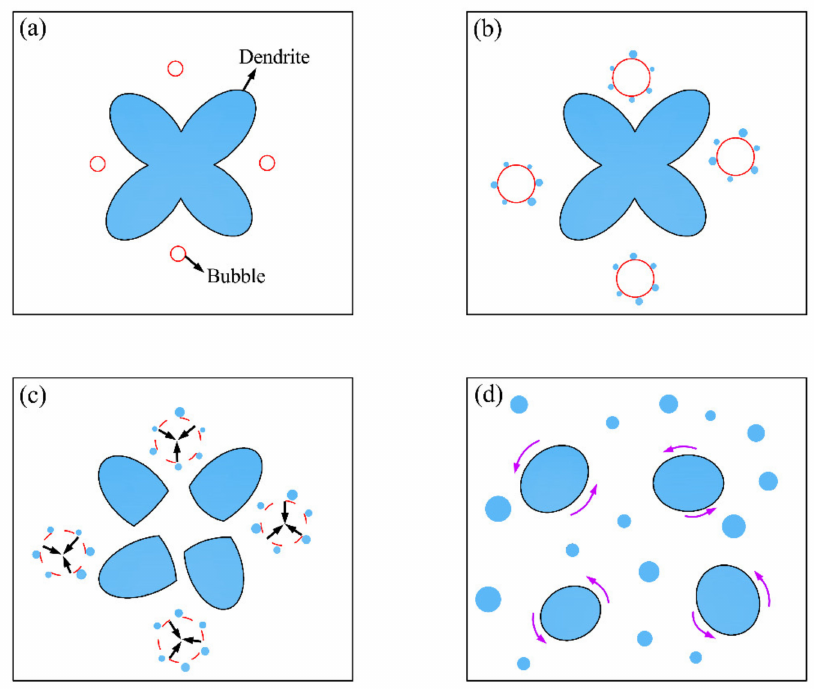
Figure 8. The refinement mechanism of the UVAW process: ( a ) formation of cavitation bubbles; ( b ) growth of cavitation bubbles; ( c ) the bursting of a cavitation bubble; and ( d ) effect of acoustic